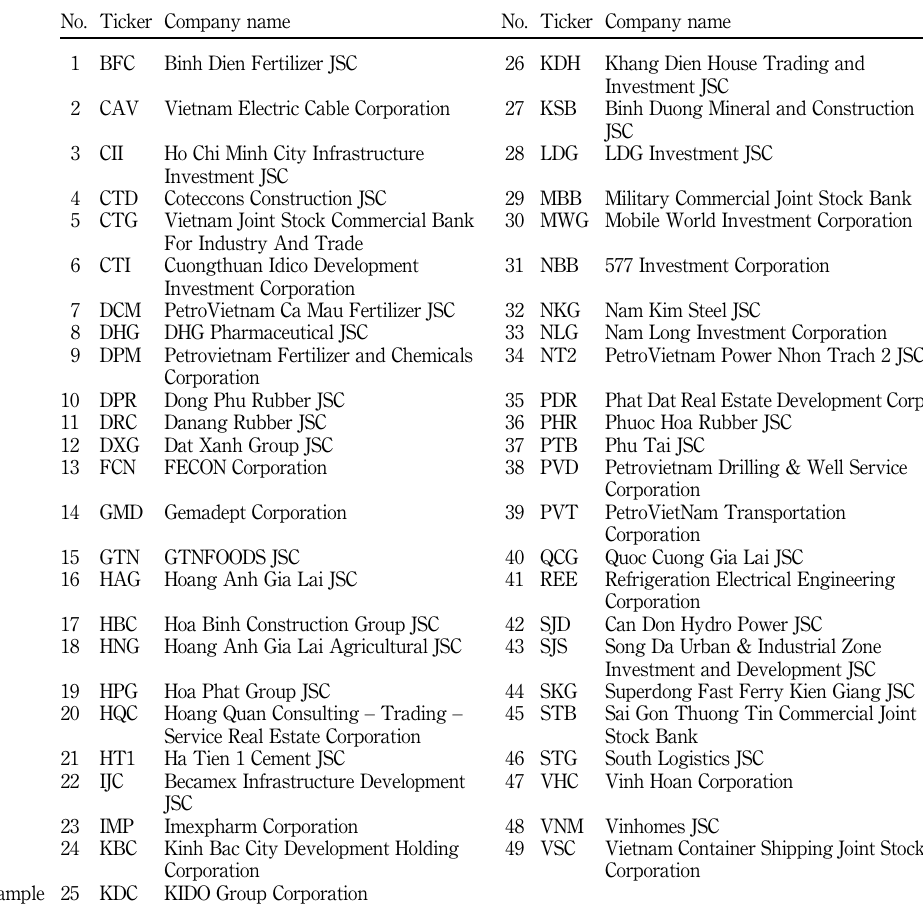
Table I. 49 stock tickers included in the